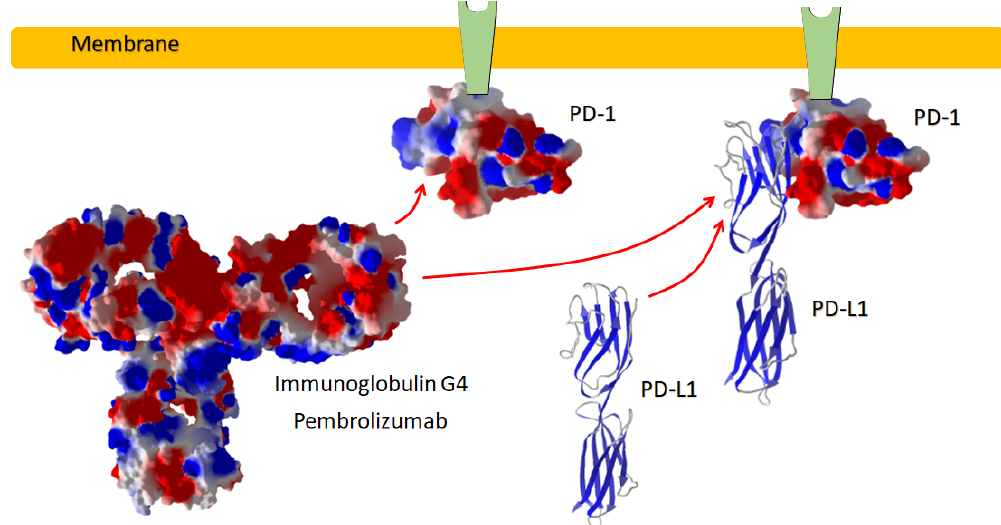
Figure 1. PD-1 inhibitor antibody. Pembroliczumab binds with the surface of the ectodomain of PD-1, preventing the immune-suppressive reaction by the binding of PD-L1 to its site on PD-1.